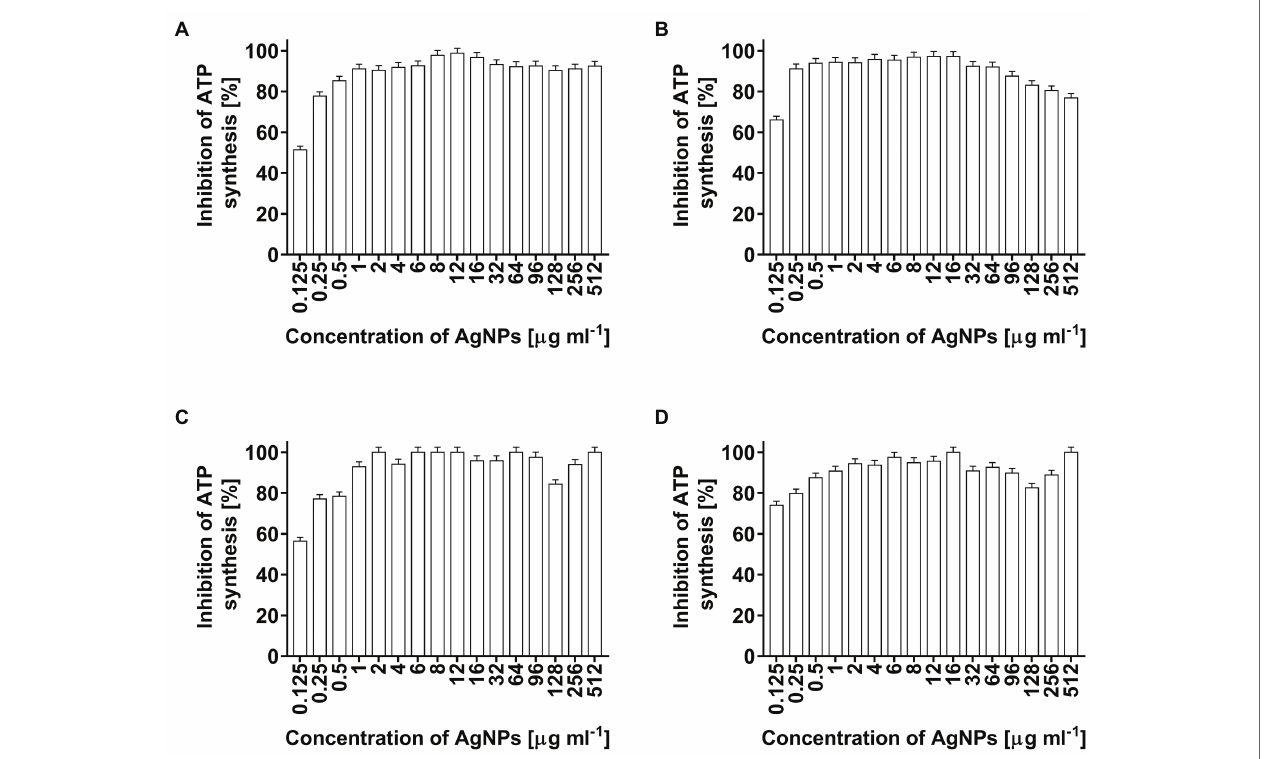
FIGURE 6 | Inhibition of ATP synthesis (%) in Escherichia coli (A) , Klebsiella pneumoniae (B) , Pseudomonas aeruginosa (C) , and Staphylococcus aureus (D) cells after treatment with biosynthesized AgNPs at different concentrations (0.125–512 μ g ml −1